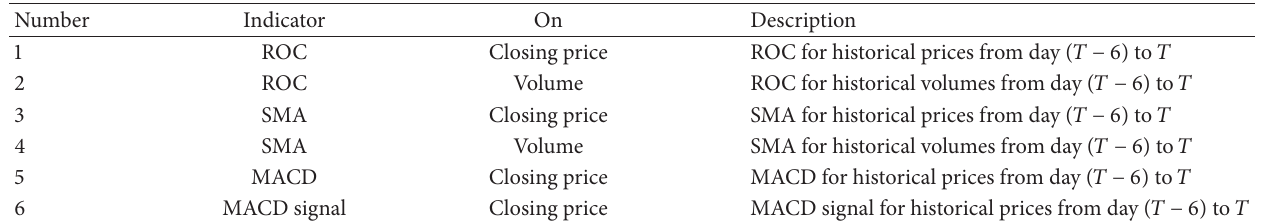
Table 6: Features from stock prices and